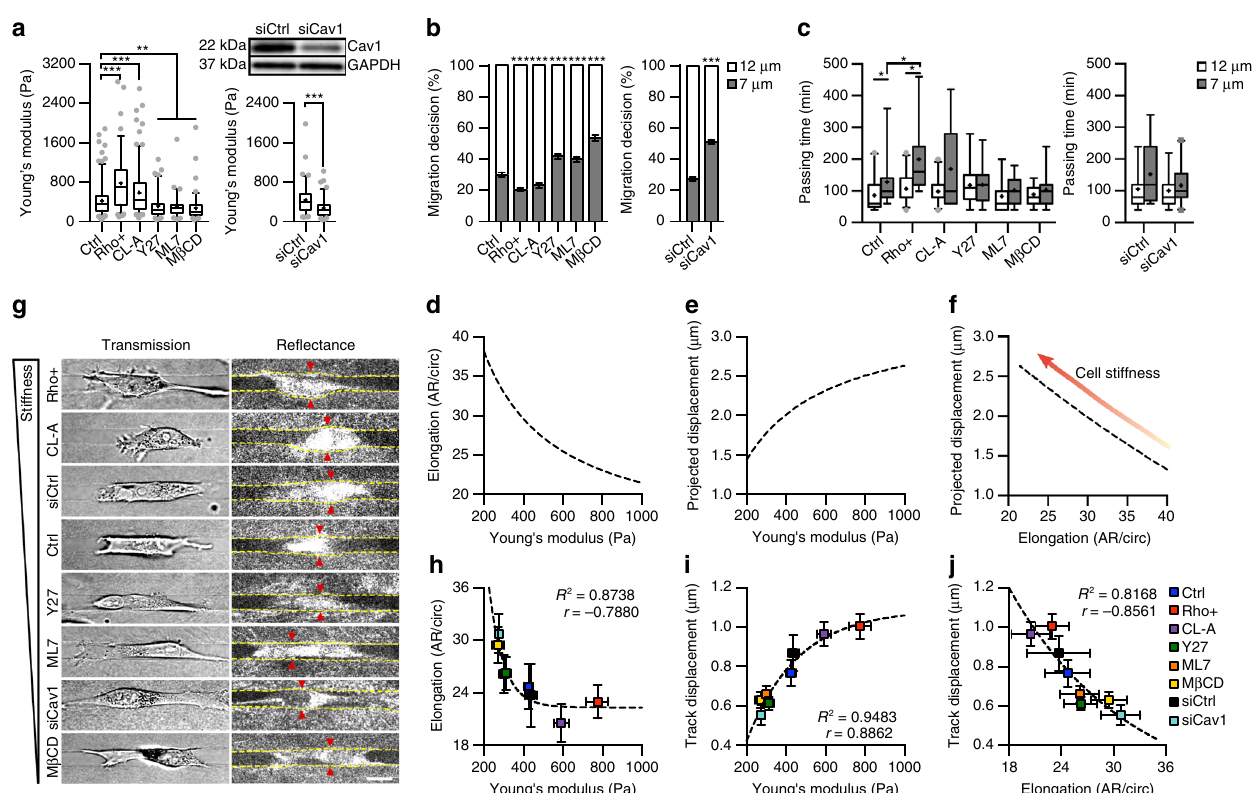
Fig. 3 Cell stiffness alters decision-making and cell mechanics during con fi ned migration. a AFM measurements of cell stiffness following pharmacological treatments and siCav1 knockdown ( n = 164, 95, 167, 91, 75, 85, 92, and 97 cells for Ctrl, Rho + , CL-A, Y27, ML7, M β CD, siCtrl, and siCav1) and western blot for Caveolin-1 following treatment with 25 nM Caveolin-1 siRNA. b , c Migration decision-making ( b ) and passing time into each branch ( c ) following treatments to alter cell stiffness ( n = 30, 34, 30, 31, 30, 28, 33, and 39 cells for Ctrl, Rho + , CL-A, Y27, ML7, M β CD, siCtrl, and siCav1). d – f Model predictions for cell deformation ( d ), track displacement ( e ), and the inverse relationship between cell elongation and track displacement ( f ) in 7 μ m tracks. g Transmitted light images showing cell morphology and confocal re fl ectance images of microtrack structure as well as cell-induced track displacement in 7 μ m microtracks (yellow lines show microtrack walls; red arrowheads show areas of matrix displacement around the cell body). h – j Experimental averages of cell elongation ( h ), track displacement ( i ), and the relationship between cell remodeling and matrix displacement ( j ) in 7 μ m microtracks as a function of cell stiffness ( n = 118, 107, 100, 135, 109, 123, 53, and 58 cells for Ctrl, Rho + , CL-A, Y27, ML7, M β CD, siCtrl, and siCav1). Data shown as median± interquartile range (box), 5th – 95th percentiles (whiskers), and mean ( + ) ( a , c ), or mean ± s.e.m. ( b , h – j ); dashed lines show one-phase decay ( h , j )